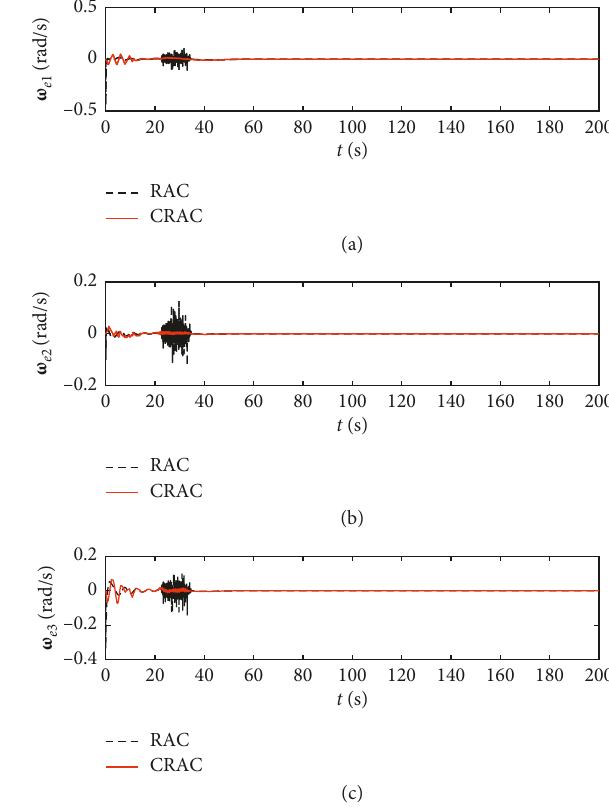
Figure 8: Time response of angular velocity tracking error.